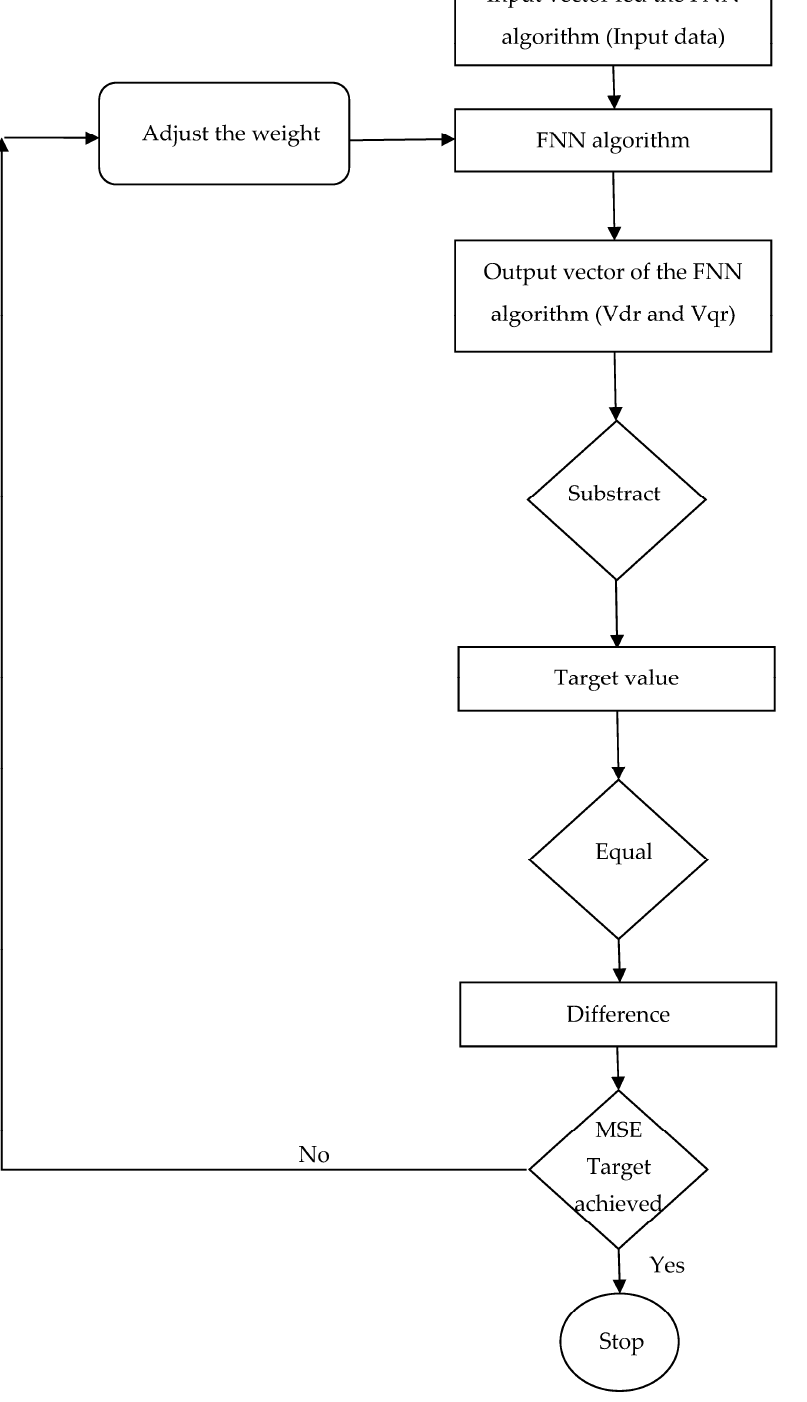
Figure A8. A learning algorithm in an FNN model.